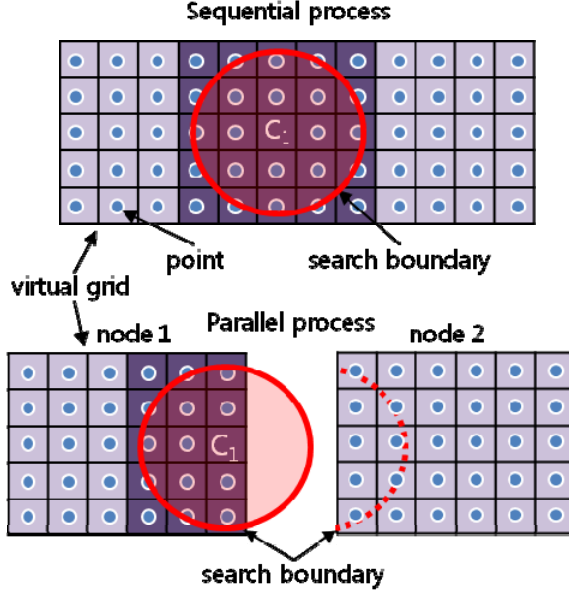
Figure 3. Different no. of searchable cells between sequential and parallel